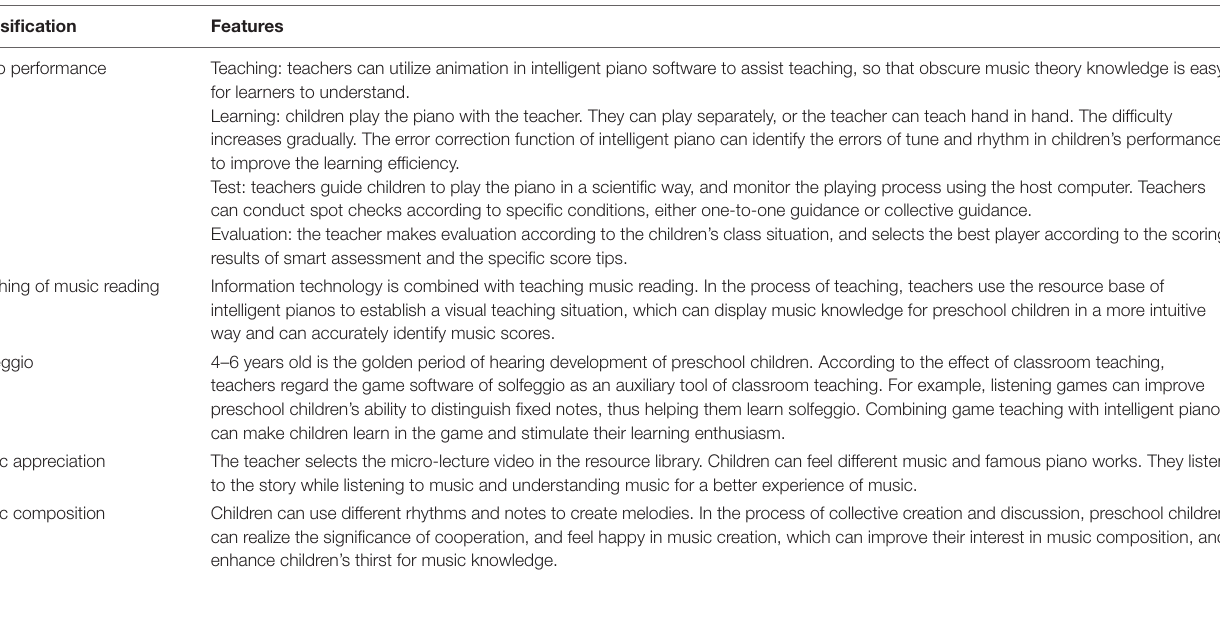
TABLE 1 | Intelligent piano offline